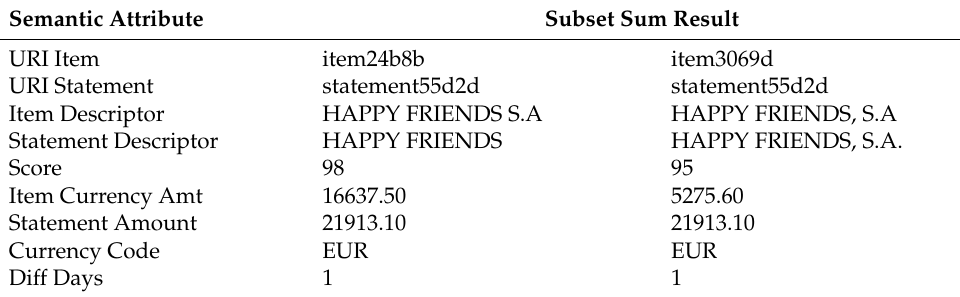
Table 12. Results of multiple invoices for a